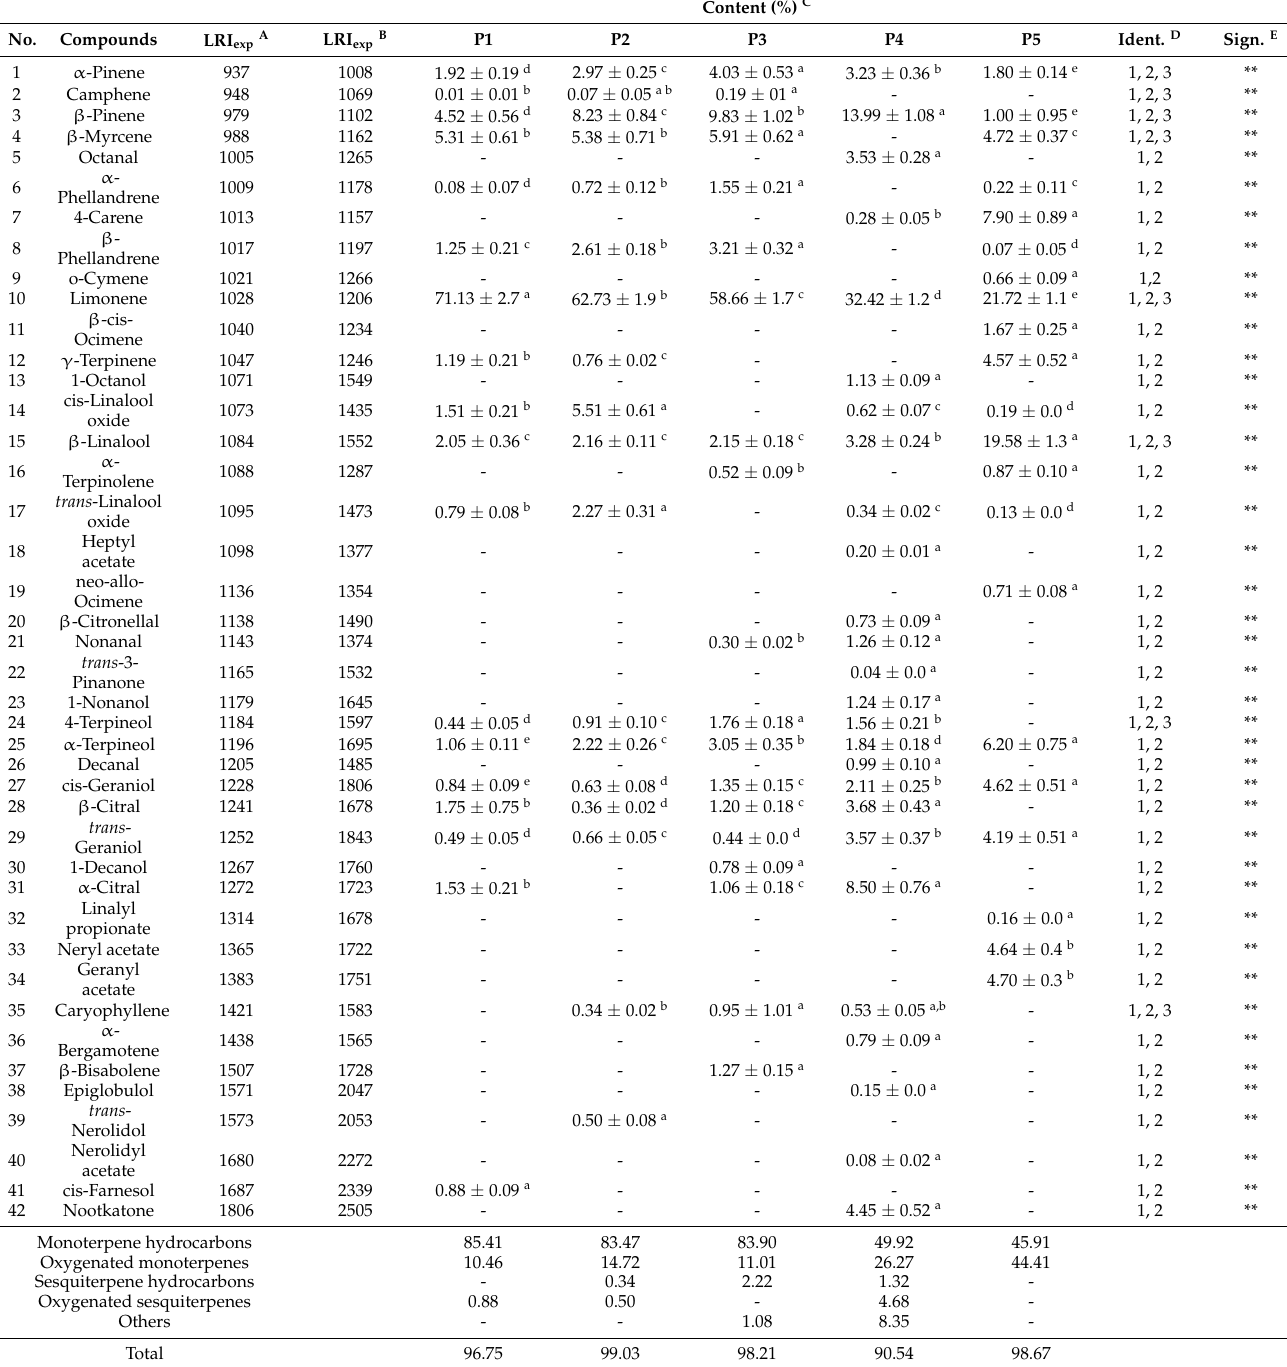
Table 1. Composition (%) of EOs of the five C. maxima cultivars collected in Sicily. Content (%)